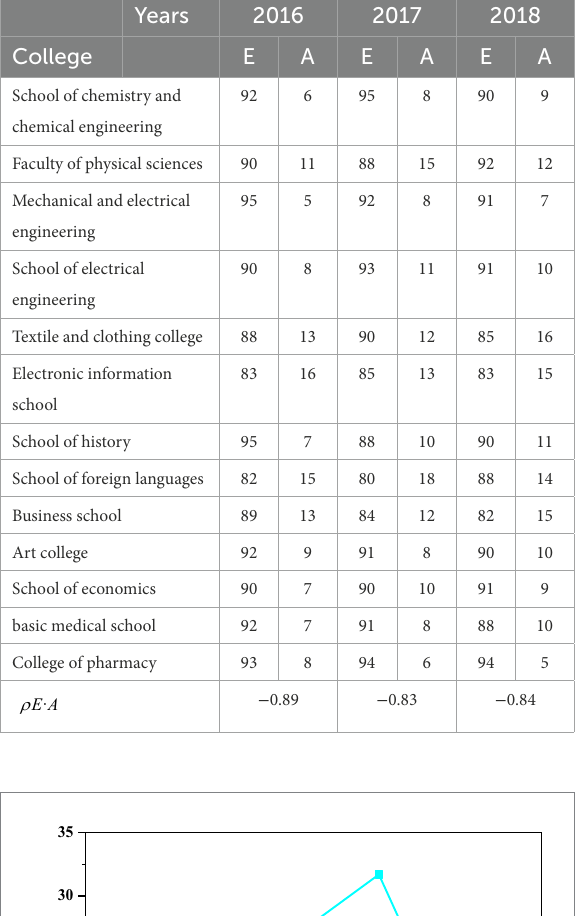
TABLE 5 The correlation between safety accidents and safety education in various colleges of a university from 2016 to 2018.